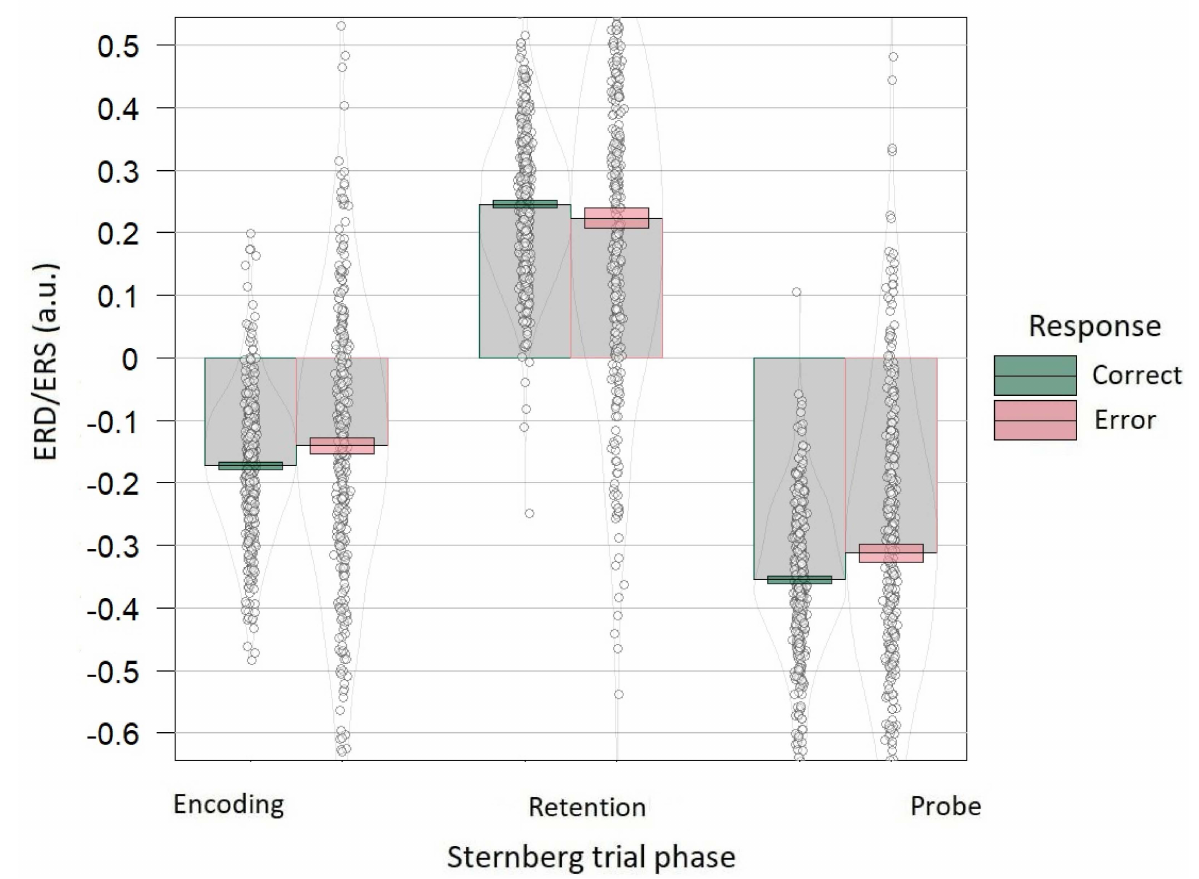
Figure 4. Event-related alpha power by response accuracy shown separately for each Sternberg trial phase. During the encoding phase, ERD was observed (300–1300 ms), during the retention phase ERS was observed (2300–3300 ms), during the probe phase, ERD was observed (3900–4300 ms). For this visualization, for each trial phase, the mean of the alpha power was normalized to minimize individual differences and added to the initial mean ± 1 standard error of the mean. Grey bars and black lines indicate means. Colored bands indicate ± 1 standard errors. Dots and density curves indicate data